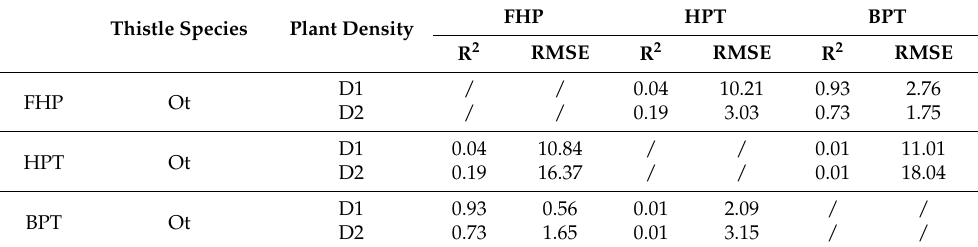
Table 9. Coefficient of determination and root mean square error (RMSE) of the linear relationship between the number of flower heads per plant (FHP), plant height (HPT) and number of branches per plant (BPT) on Onopordum tauricum Willd. (Ot) at two plant densities compared. FHP HPT BPT Thistle Species Plant Density R 2 RMSE R 2 RMSE R 2 RMSE D1 / / 0.04 10.21 0.93 2.76 FHP Ot D2 / / 0.19 3.03 0.73 1.75 D1 0.04 10.84 / / 0.01 11.01 HPT Ot D2 0.19 16.37 / / 0.01 18.04 D1 0.93 0.56 0.01 2.09 / / Ot D2 /